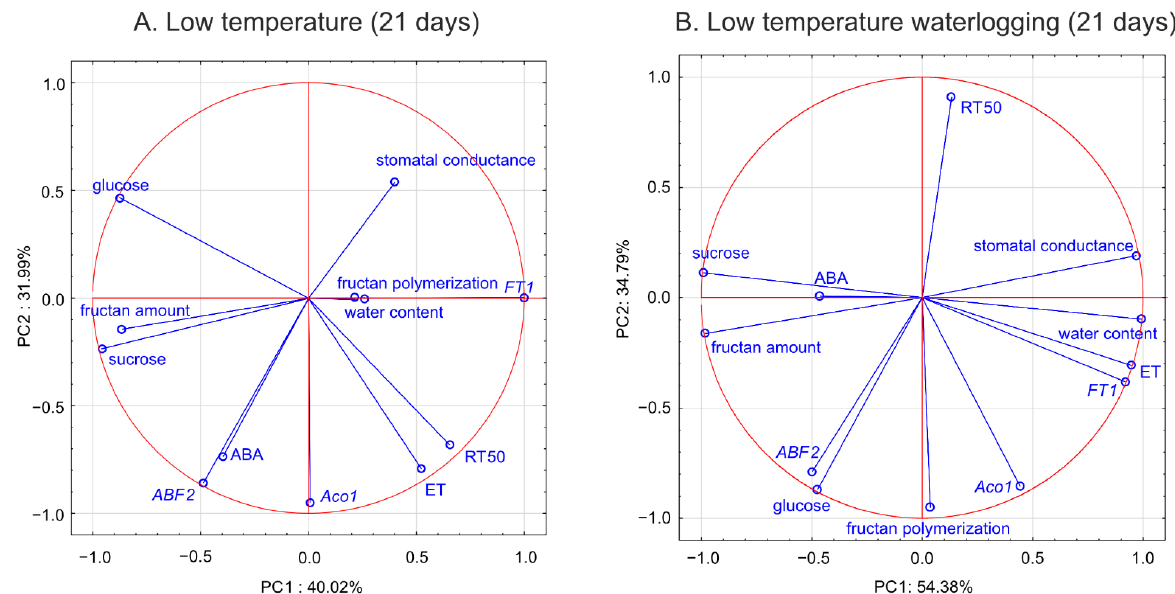
Figure 13. Principal component analysis of analyzed parameters performed in Lolium perenne genotypes after 21 days of low temperature ( A ) and low temperature waterlogging ( B ). The first two principal components explained 72.01% and 89.17% of the total variability in the control and waterlogged plants, respectively.